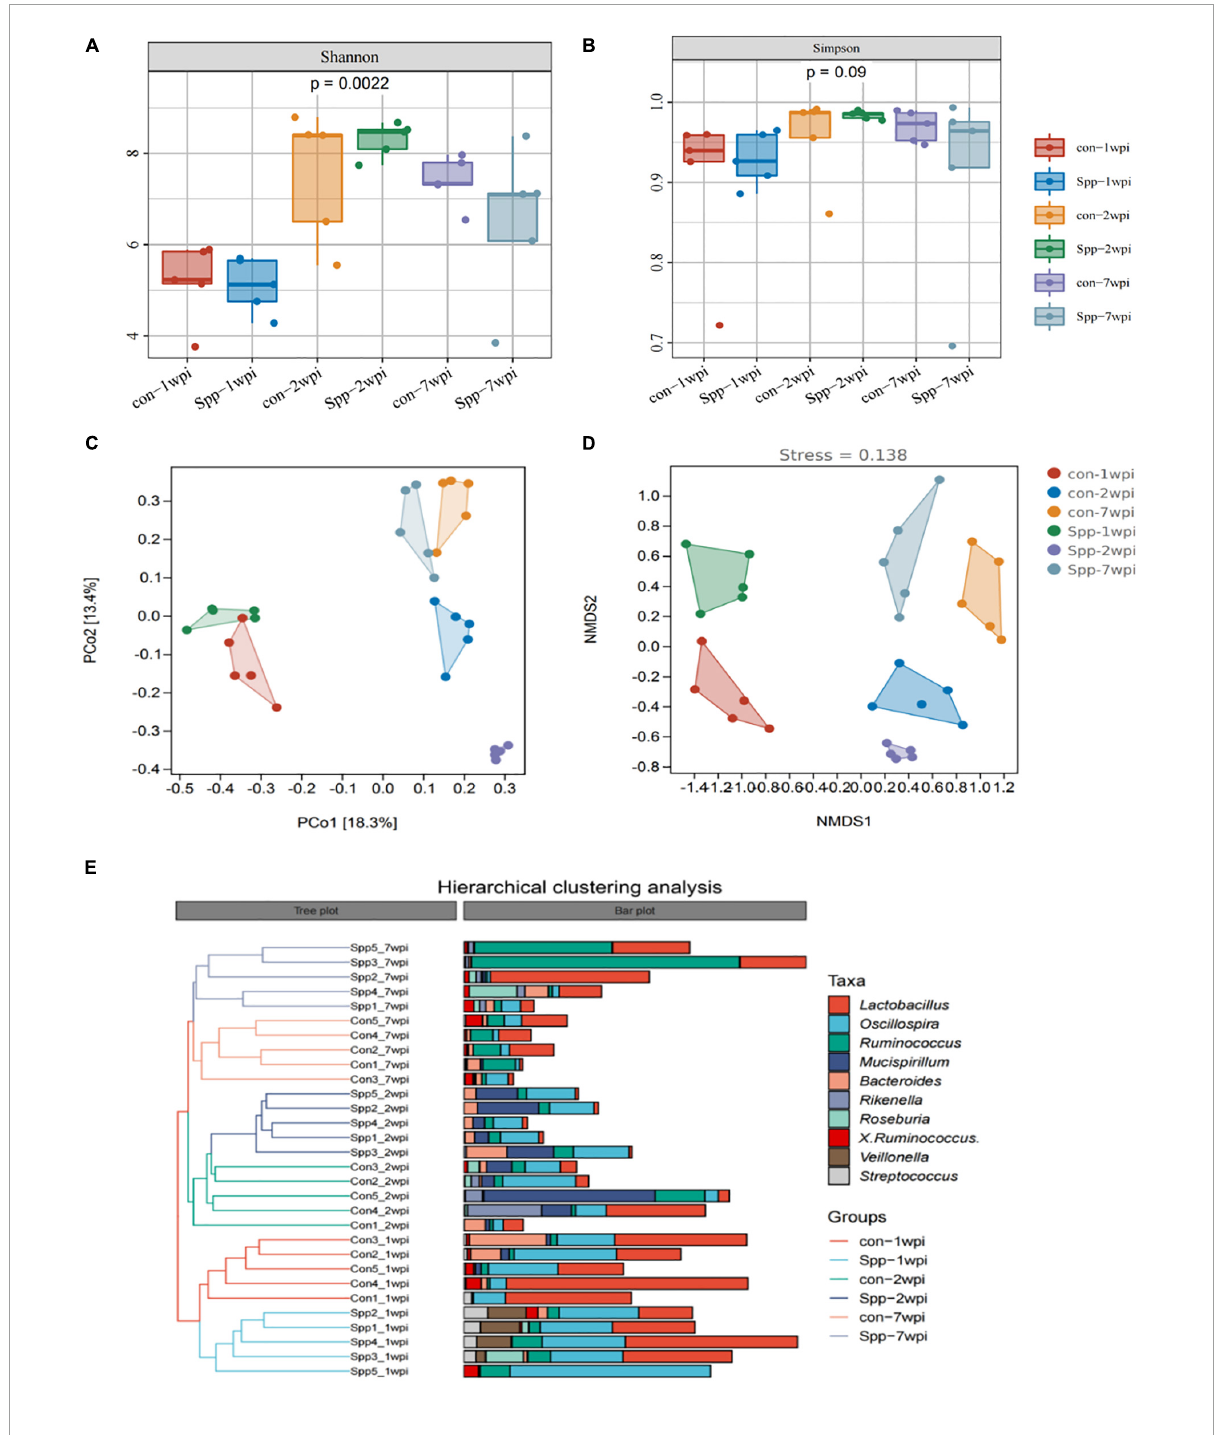
FIGURE4 Neonatal S. pneumoniae infection alters gut microbial community structure. (A) The alpha diversity of gut microbiota from the mock-infected control- and neonatal S. pneumoniae infection ( S . pp)-treated mice in the breastfeeding period (1 wpi), infancy (2 wpi), and adulthood (7 wpi) was represented by Shannon indices. (B) The alpha diversity of gut microbiota from the mock-infected control- and neonatal S. pneumoniae infection ( S . pp)-treated mice was represented by Simpson indices at different stages. (C) Beta-diversity analysis of relative abundances of the entire microbiota using principal coordinate analysis (PCoA) with Bray-Curtis dissimilarity index, followed by the PERMANOVA significance test. (D) Beta-diversity analysis of whole-microbiota relative abundance with two-dimensional non-metric multidimensional scaling of Bray-Curtis dissimilarity distance metric (2D stress value = 0.138). (E) Hierarchical clustering of mock-infected control- and S . pp-treated mice in the breastfeeding period, infancy, and